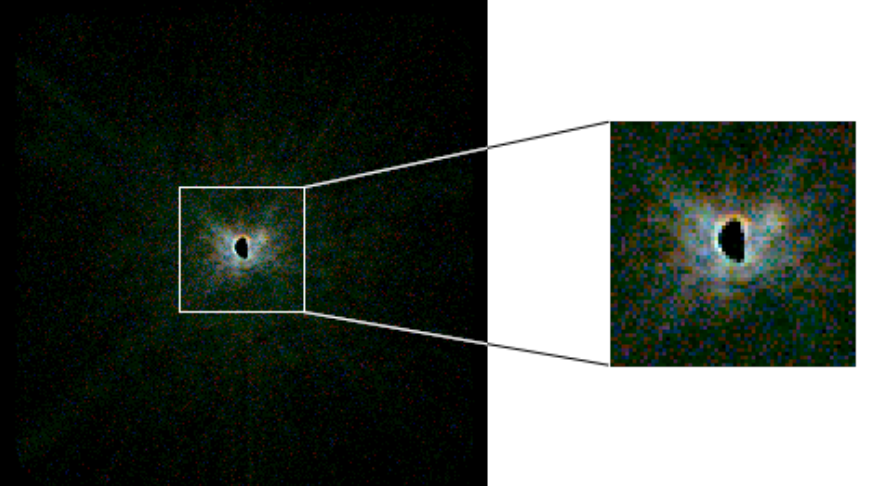
Figure 4. Example of the false colour output being used during a ptychography beamtime. The pink spectrum of the beam has been split over the red, green and blue ranges and visualizes the energy-dependent diffraction caused by the optics used during the beamtime. The three colour planes have been autoscaled to fill the full 8 bit dynamic range of each colour on a logarithmic scale. The red, green and blue energy ranges are respectively 6.8 to 7.6keV, 7.6 to 8.4keV, and 8.4 to 9.2keV. A two minute exposure time was used, and the global flux was 3.1 × 10 3 phs − 1 cm − 2 , with hotspots of 9.6 × 10 4 phs − 1 cm − 2